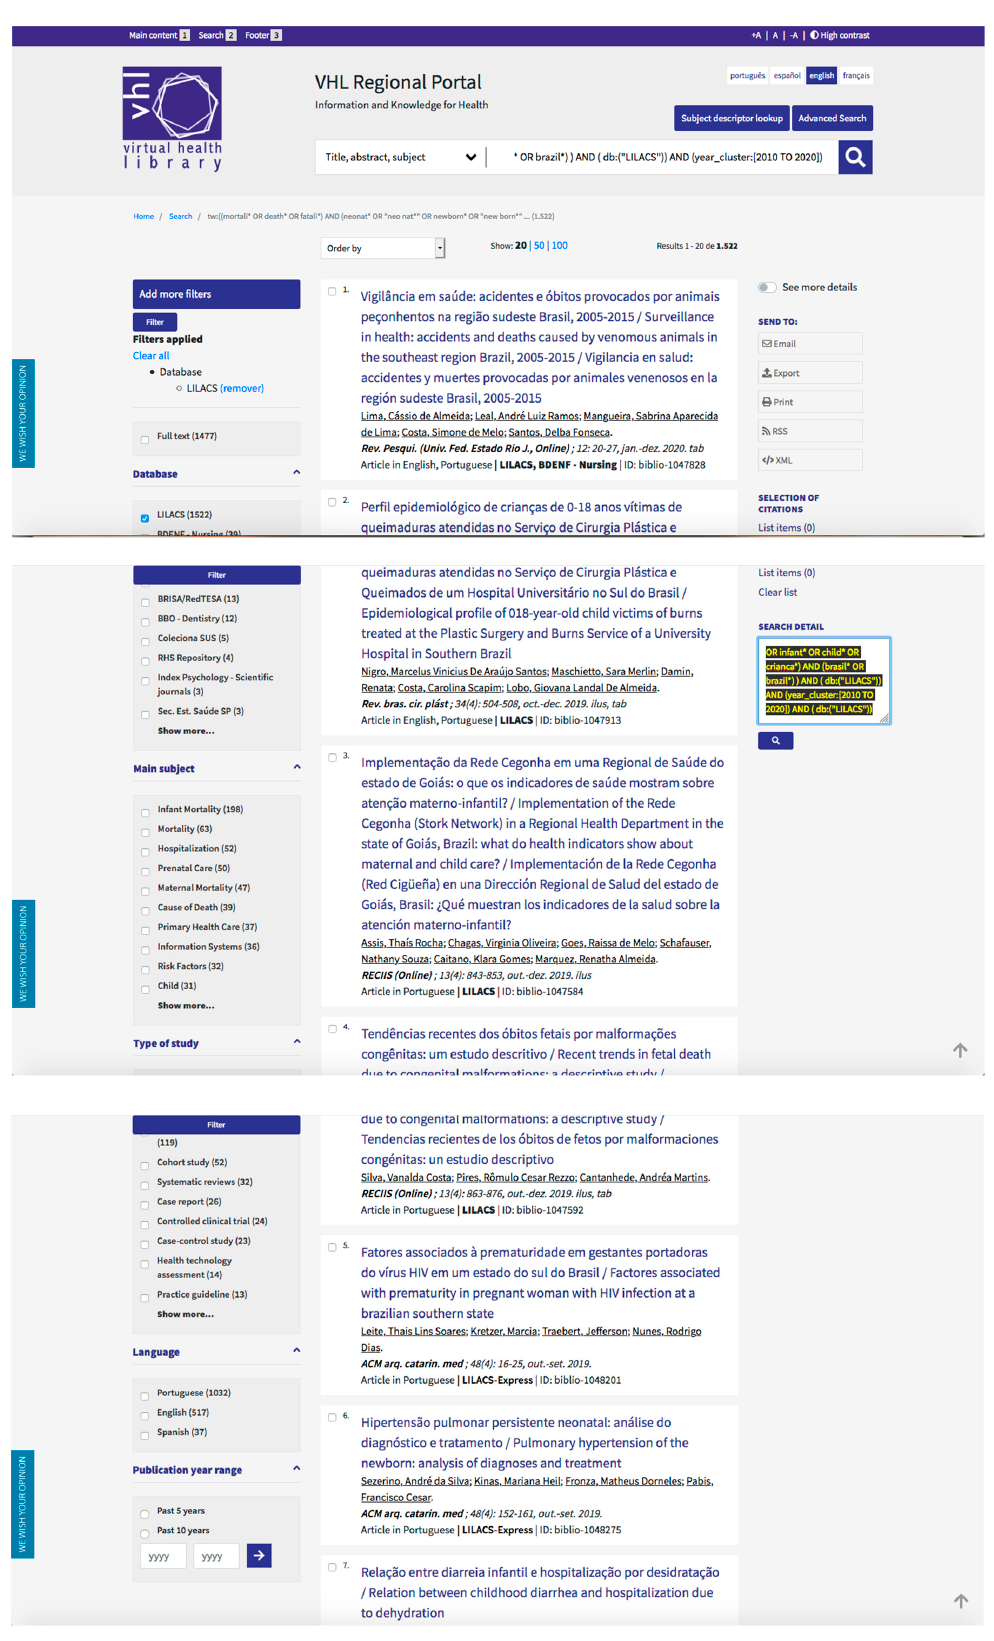
Figure A2. Screen shot research LILACS. Concept 1.